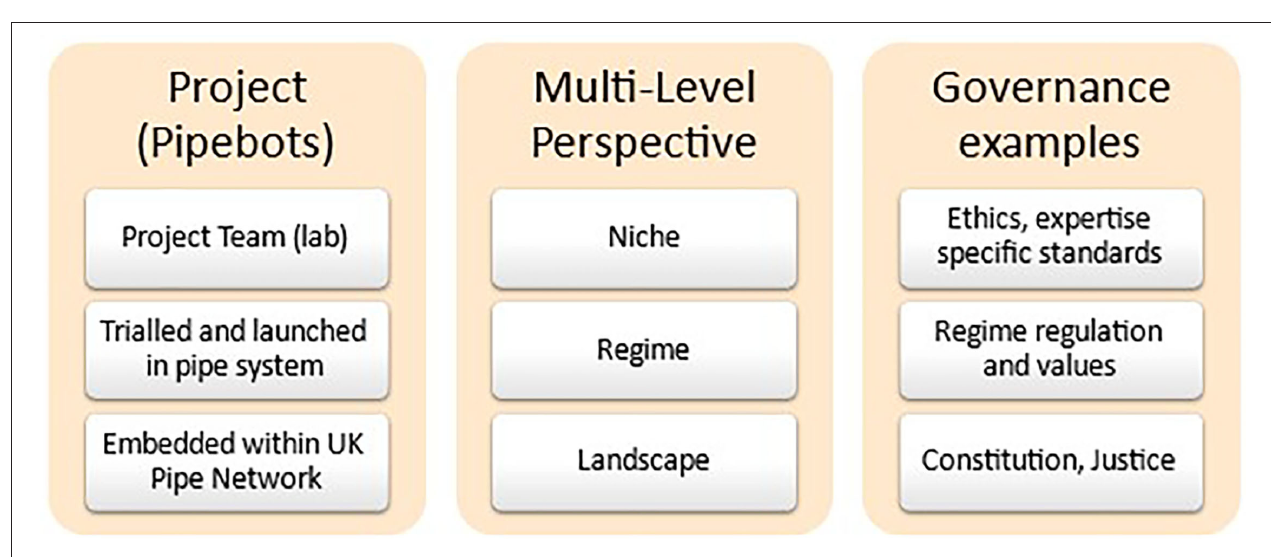
FIGURE 2 | The multi-level perspective interpreted for